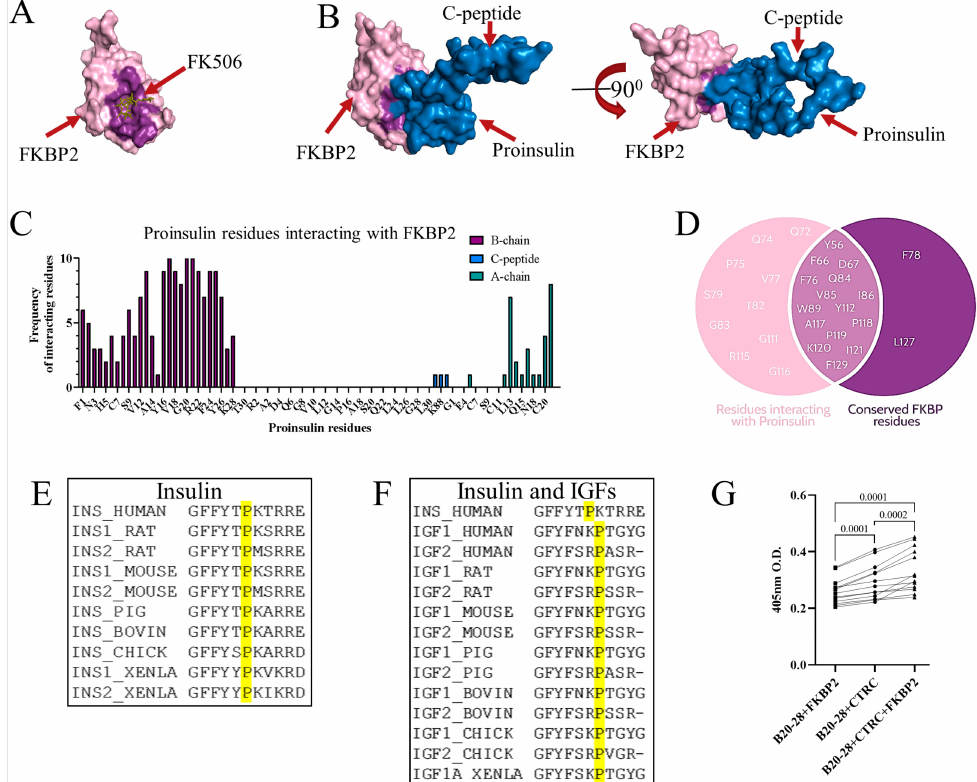
Figure 2. In silico modeling of proinsulin interaction with FKBP2, identification of proinsulin isomers, and demonstration of FKBP2 as a proinsulin isomerase. FKBP2 binding to its inhibitor FK506 (( A ), crystal structure PDB: 4NNR) and proinsulin (( B ), FKBP2 crystal structure PDB: 2PBC, proinsulin NMR structure PDB: 2KQP, blue) in the representative in silico models. In both structures, the residues involved in the interaction are highlighted in purple. The models were generated on the ZDOCK server. ( C ). The panel shows the frequency of proinsulin residues interacting with FKBP2 in the top ten generated interaction models between FKBP2 and proinsulin (2PBC and 2KQP structures, respectively). ( D ). Overlap between proinsulin interacting residues and conserved residues within FKBP2. The data displayed are the combined data from 100 FKBP2–proinsulin interaction models. The conserved residues are highlighted in dark purple. ( E , F ). Alignment of human